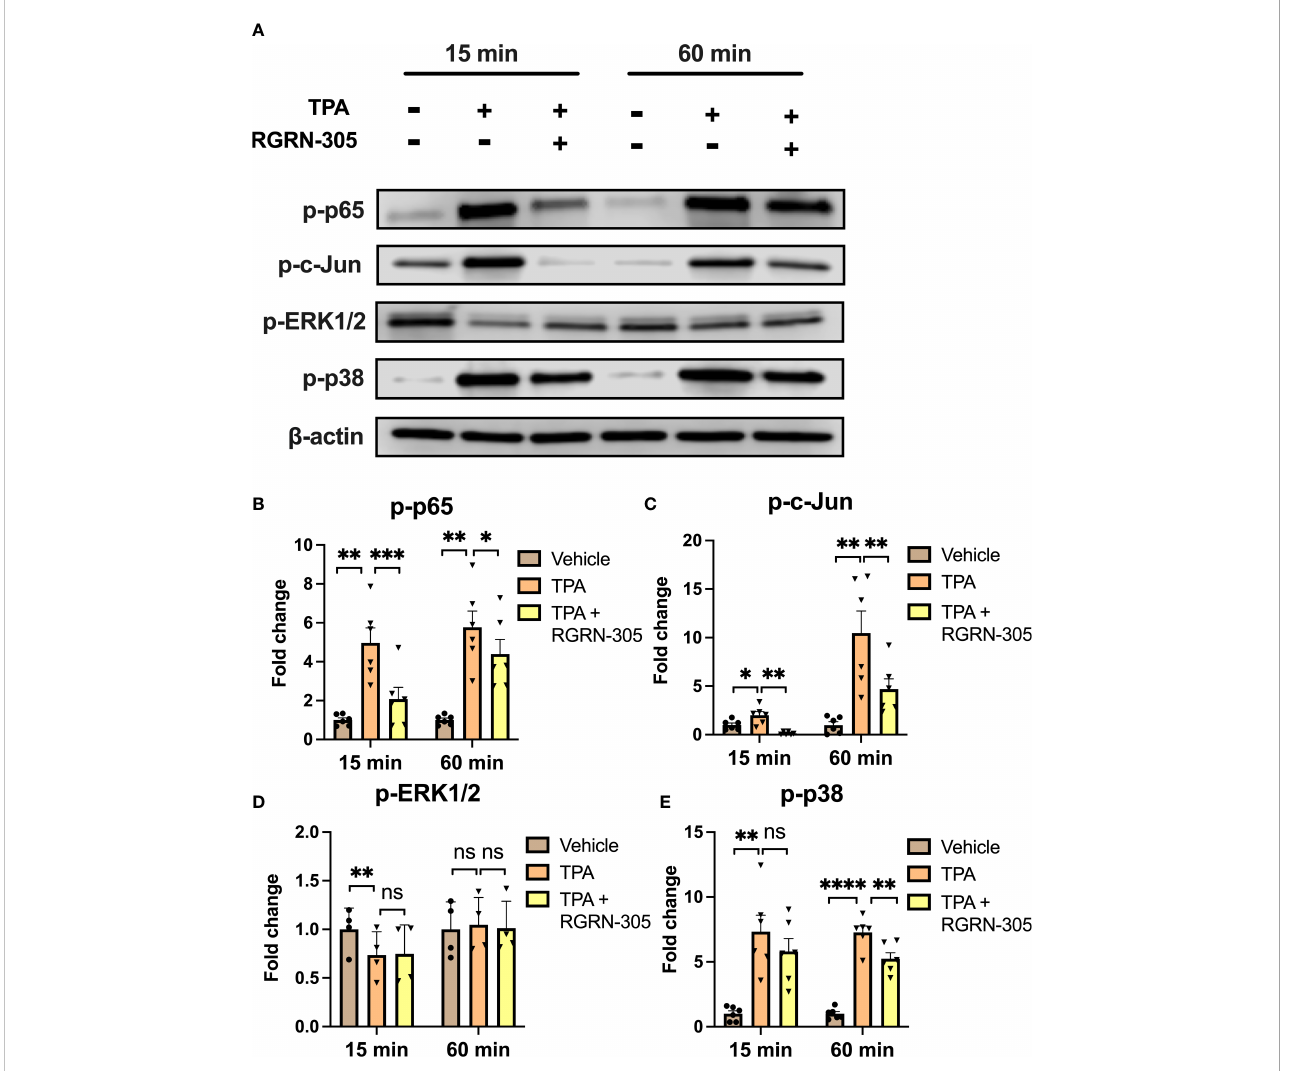
FIGURE 3 Effects of RGRN-305 on key signaling pathways in primary human keratinocytes. Phosphorylation status of key signaling molecules was determined in primary human keratinocytes preincubated with RGRN-305 (5 µM) and stimulated with TPA (100 nM) for 15 minutes and 60 minutes. (A) Representative Western blots and densitometric analyses of p-p65 (B) , p-c-Jun (C) , p-ERK1/2 (D) and p-p38 (E) . To normalize protein expression, b -actin was used as a loading control. Data are shown as mean ± SEM fold change relative to vehicle (3 independent experiments, n = 6). *p < 0.05, **p ≤ 0.01, ***p ≤ 0.001, ****p ≤ 0.0001. ns, not signi fi cant. TPA,